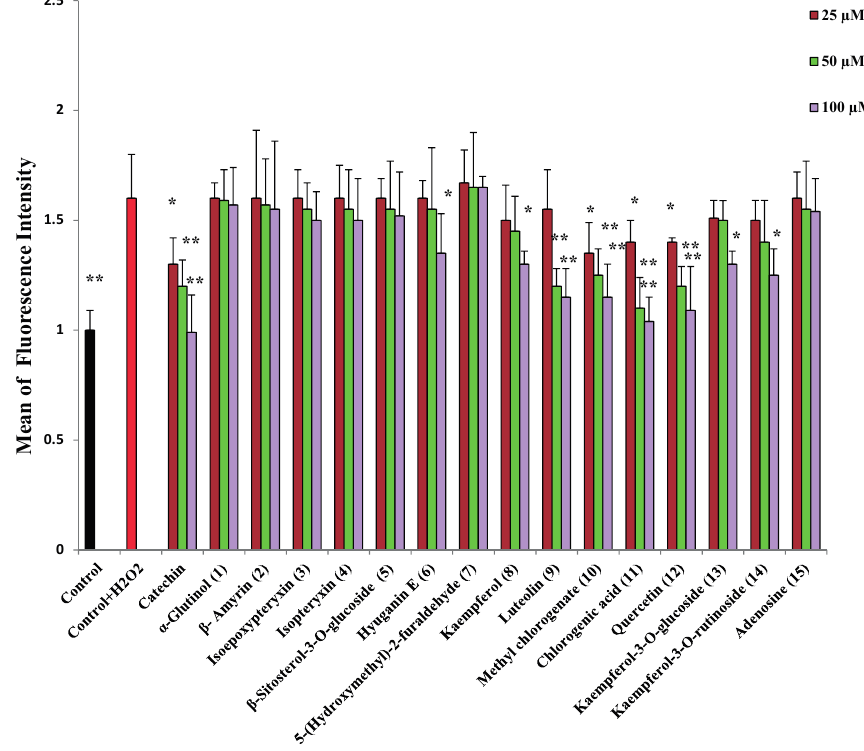
Figure 4. Fluorescence intensity of neuro-2A cells treated with different concentrations of sample and treated with H 2 O 2 (600 µM) for 30 min. All values are means ± SDs ( n = 3). * and ** Significant difference from fluorescence intensity of H 2 O 2 treatment at p < 0.05 and p < 0.01,